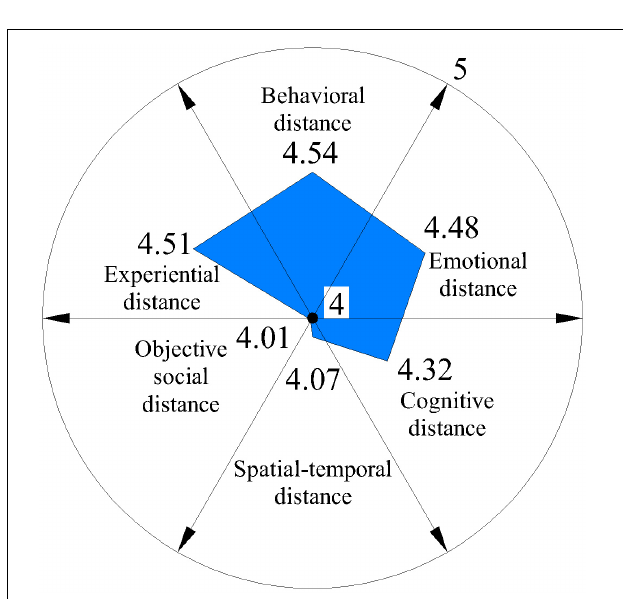
FIGURE 6 | Average psychological distance distribution on exclude